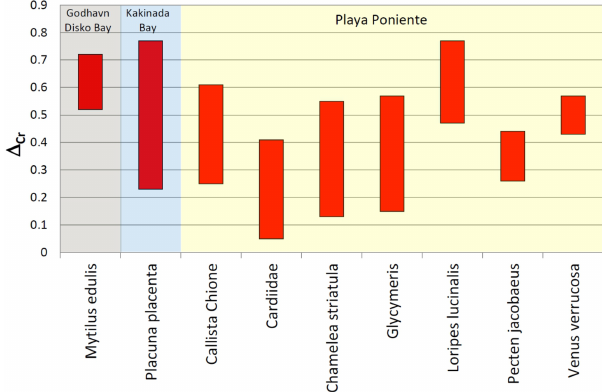
Figure 9. Bar graph showing the conservative offset ranges ( (cid:49) Cr ) of δ 53 Cr values of bivalve species from ambient seawater. The larger range of Placuna placenta is due to within-shell hetero- geneities probably resulting from seasonal surface seawater fluc- tuations which are smoothed out by the bulk shell analyses of the other species (see text for